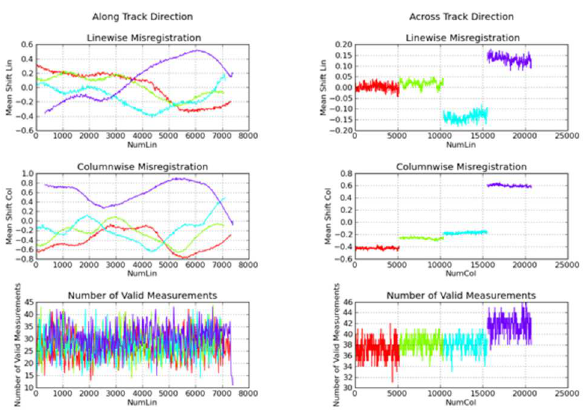
Figure 6 Example of misregistration profiles obtained with 4 spectral bands couples before attitude refinement and after quaternion filtering. The couples of bands used are B05-B07 (red), B06-B07 (blue), B09-B10 (green), B06-B05 (purple). Units are